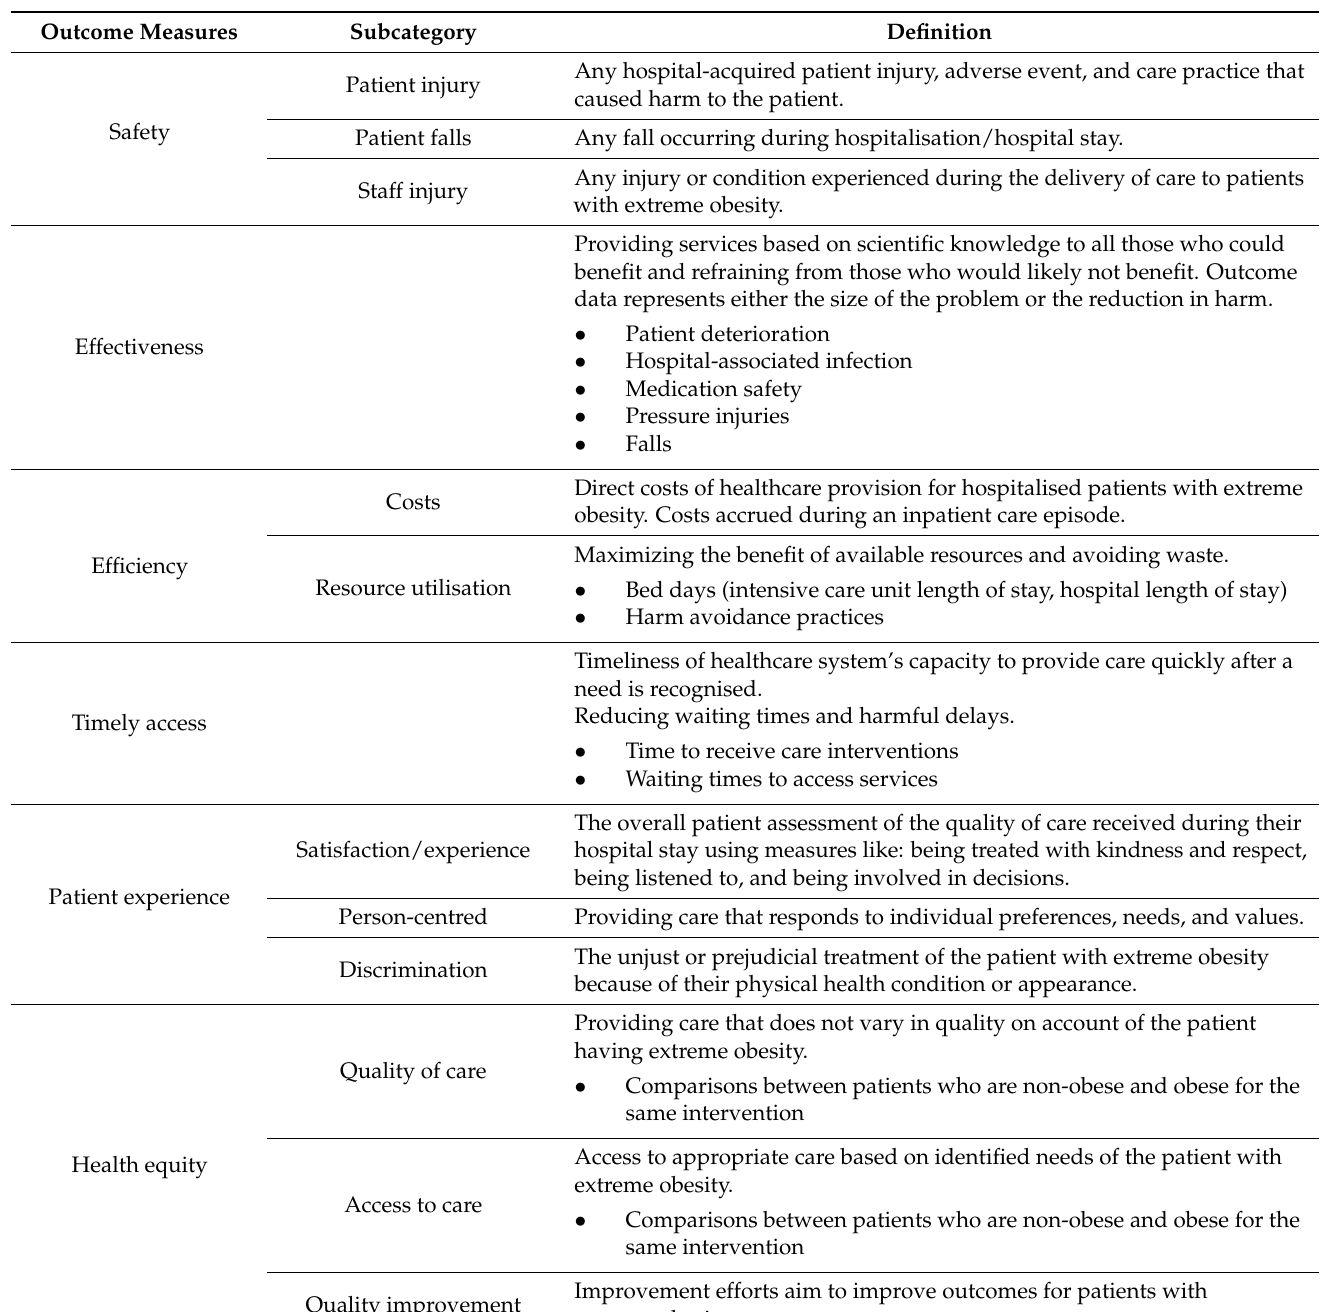
Table 2. Outcome